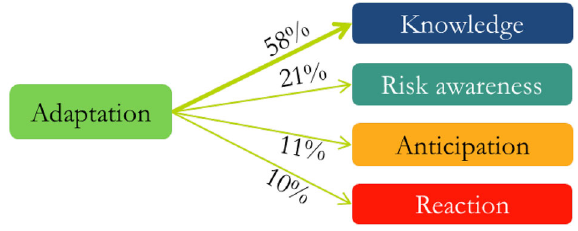
Fig. 4 Dependencies identified by the expert panel between adapta- tion and other strategies to manage vulnerability to flooding. Source : Guillier